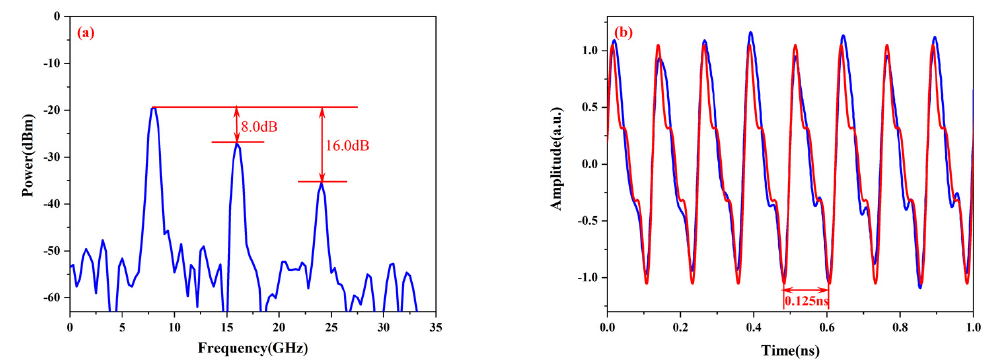
Figure 6. Experiment results. ( a ) Electrical power spectra and ( b ) waveforms of the generated sawtooth waveform with repetition rates of 8 GHz. (Blue curve in the figure is the measured result, and the red curve is the theoretical result).